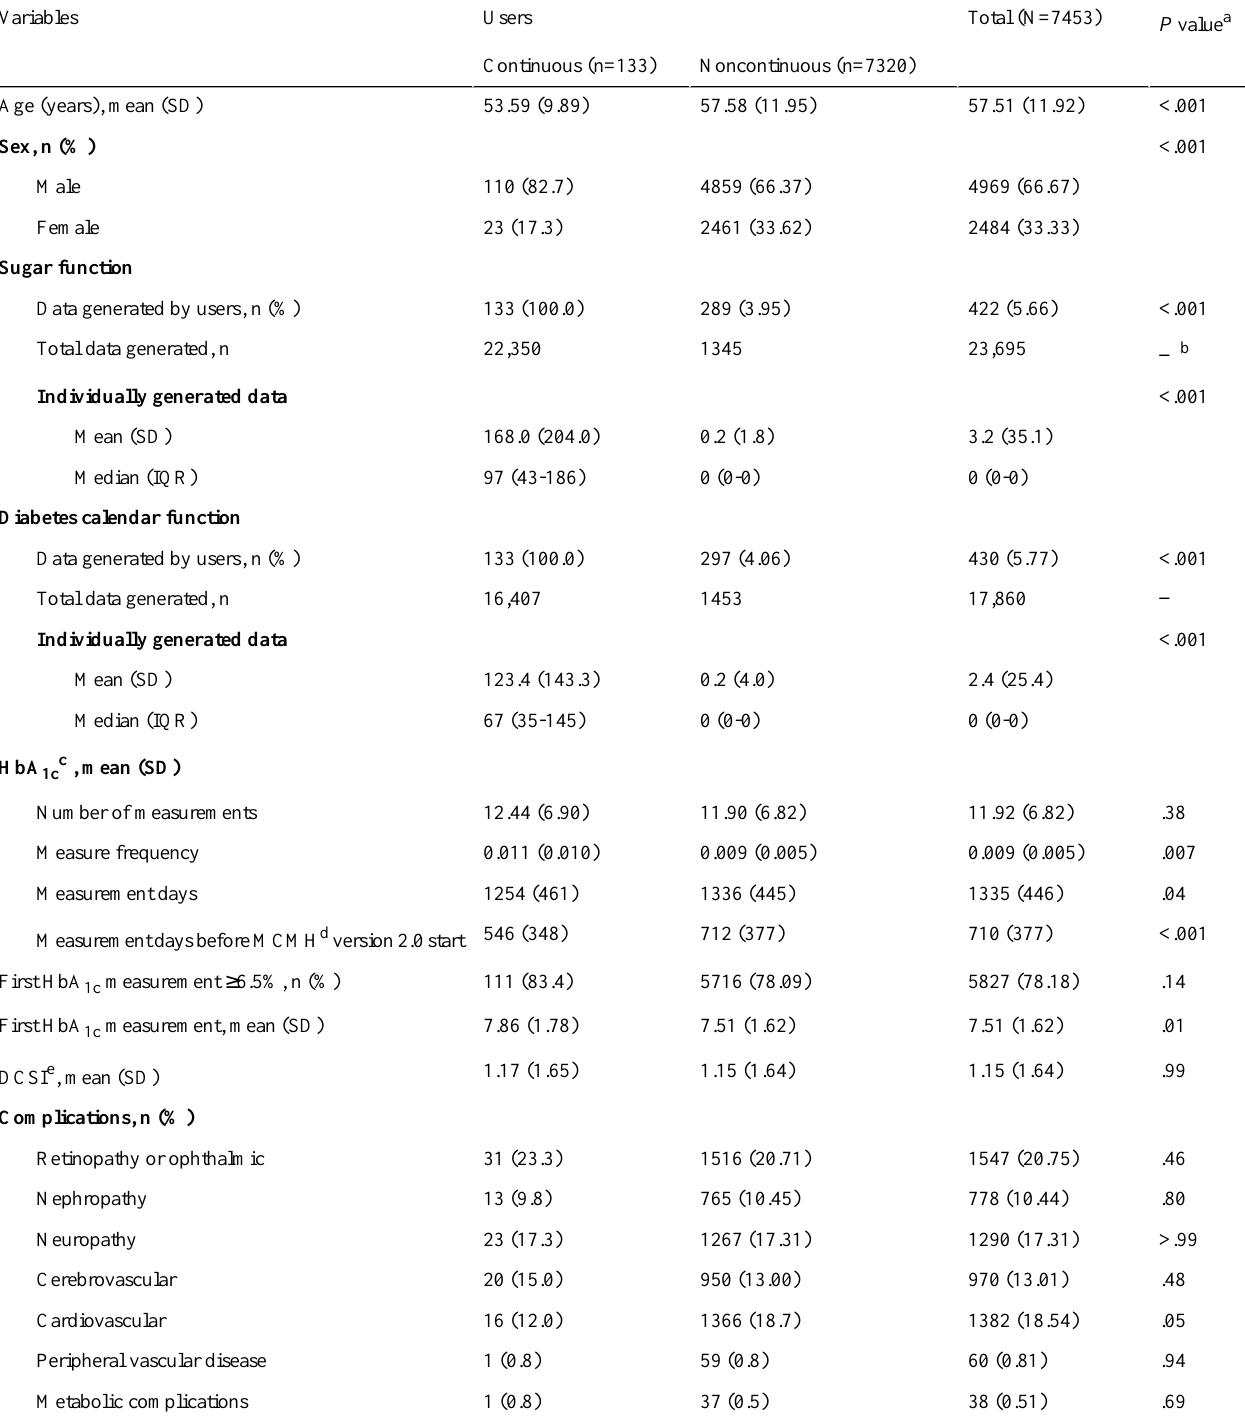
Table 1. General characteristics of continuous and noncontinuous users.